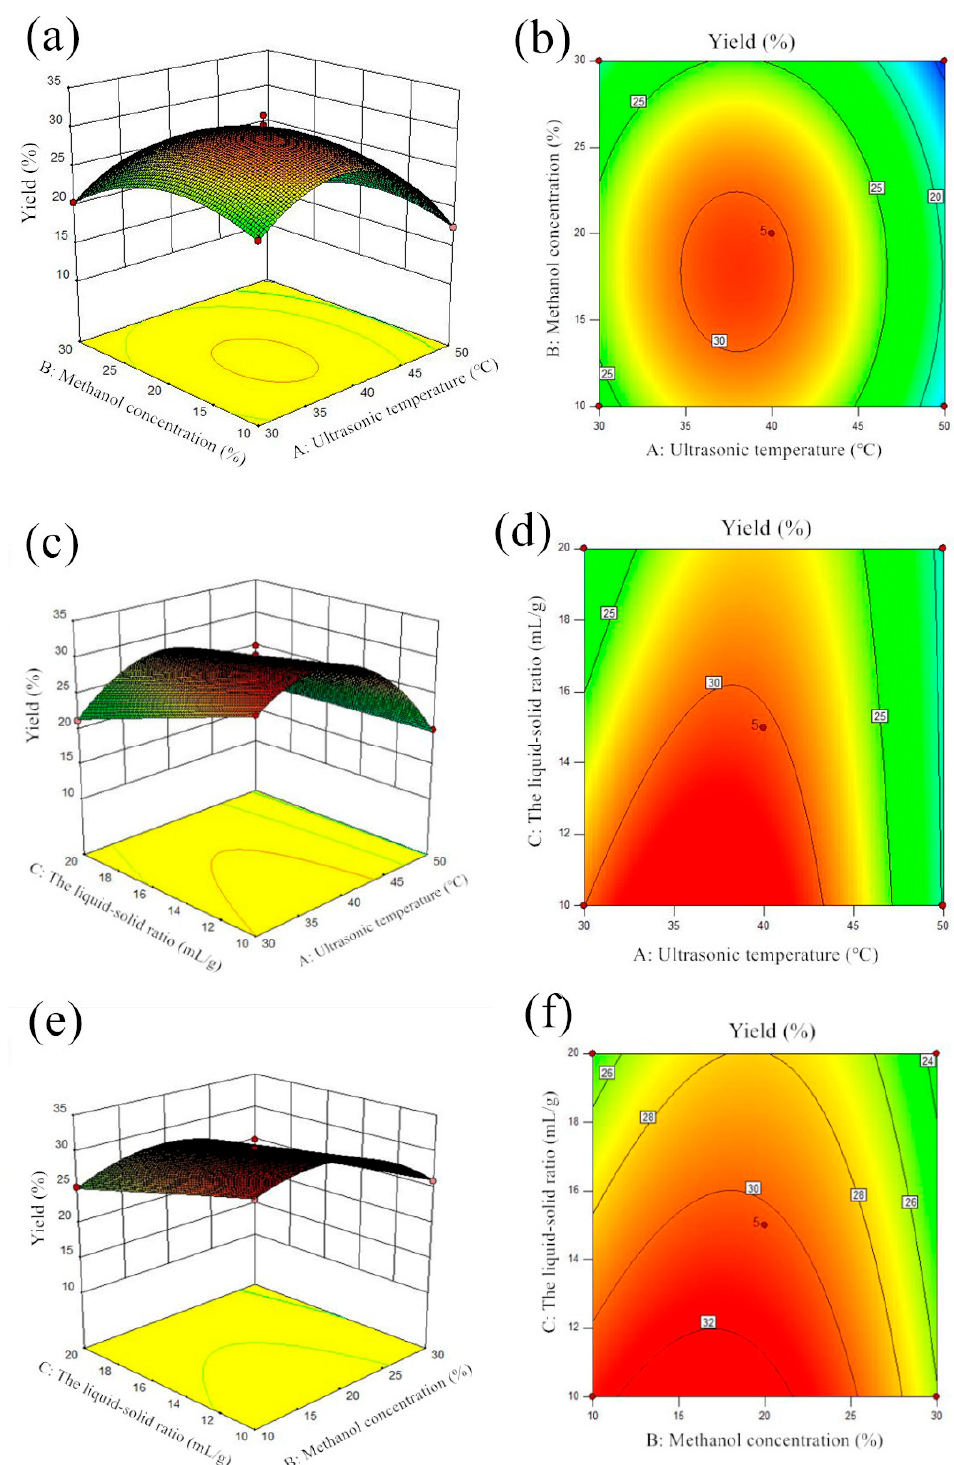
Figure 2. Contour map and response surface plot. ( a , b ) Interaction plot of ultrasonic temperature and methanol concentration (the liquid-solid ratio is constant at 15:1 mL/g). ( c , d ) Interaction plot of ultrasonic temperature and the liquid-solid ratio (the methanol concentration is constant at 20%). ( e , f ) Interaction plot of methanol concentration and the liquid-solid ratio (the ultrasonic temperature is constant at 40 °C).